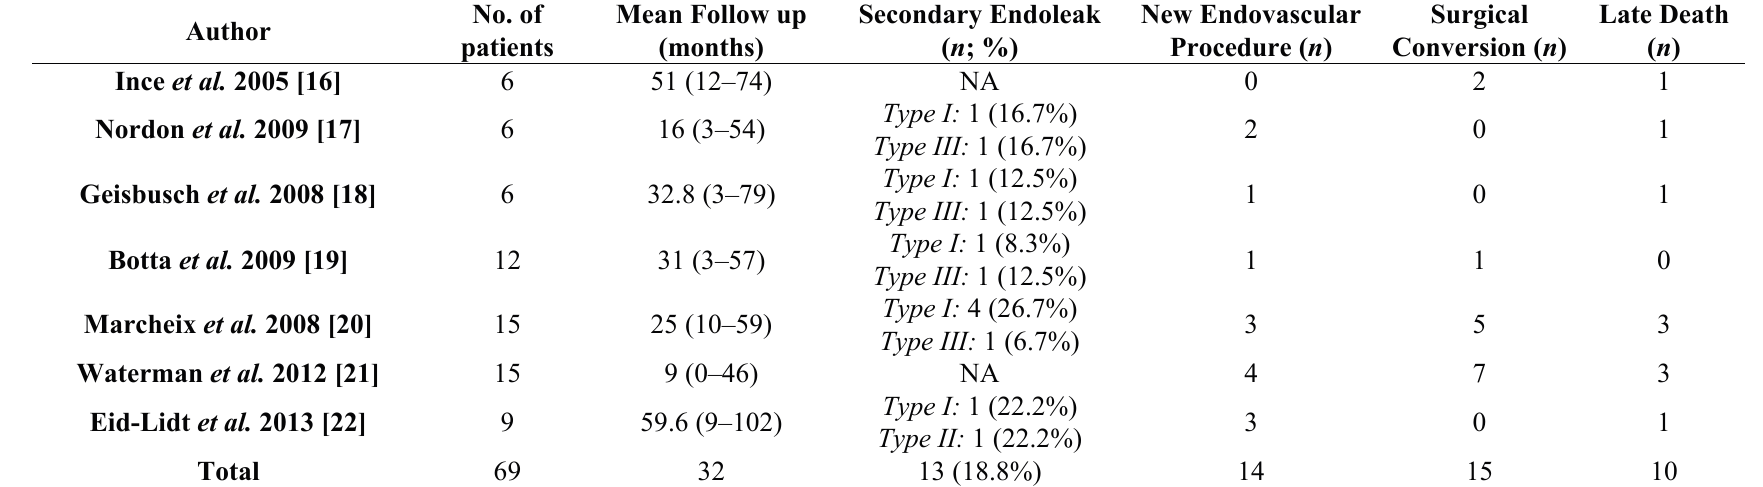
Table 2. TEVAR in Marfan Syndrome: Follow